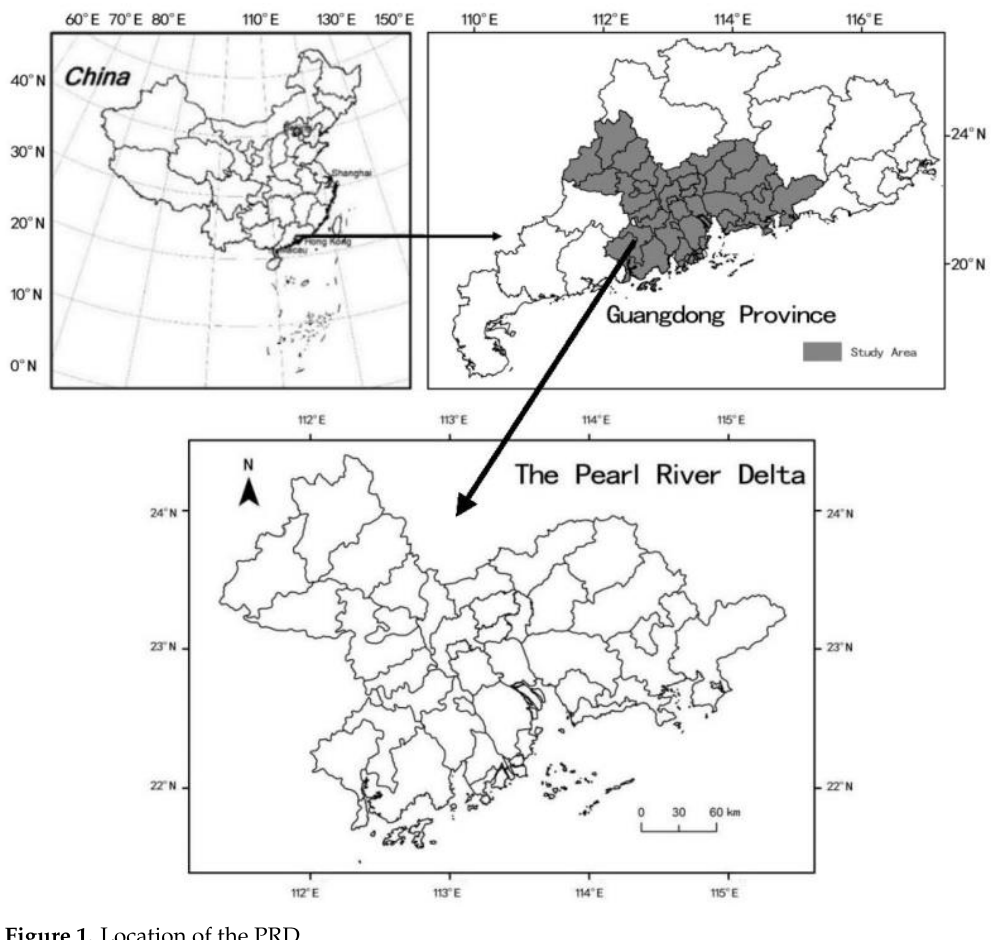
Figure 1. Location of the PRD. Table 1. The economic profile of secondary industries in the PRD from 1990 to